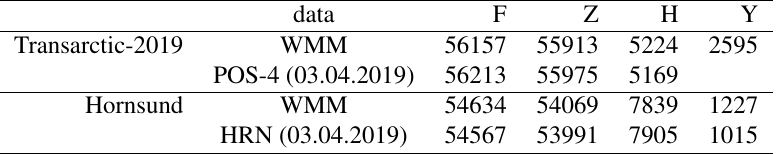
Table 1. Comparison of Earth’s magnetic field elements from observations and from model